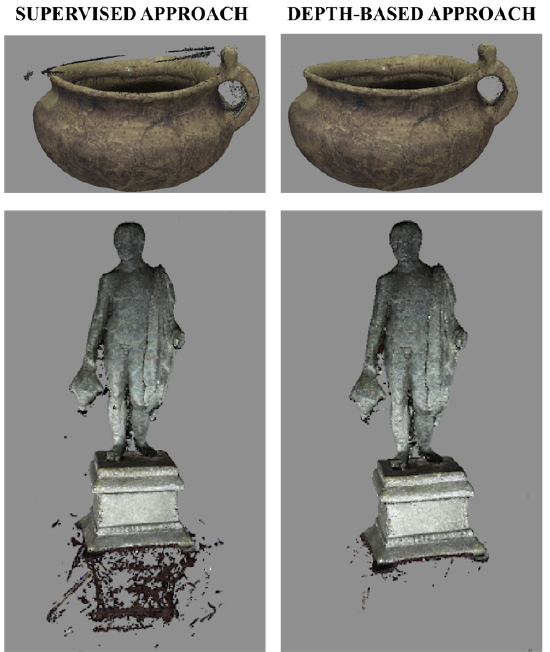
Figure 9. Dense point cloud results applying image masks within the MVS reconstruction process.